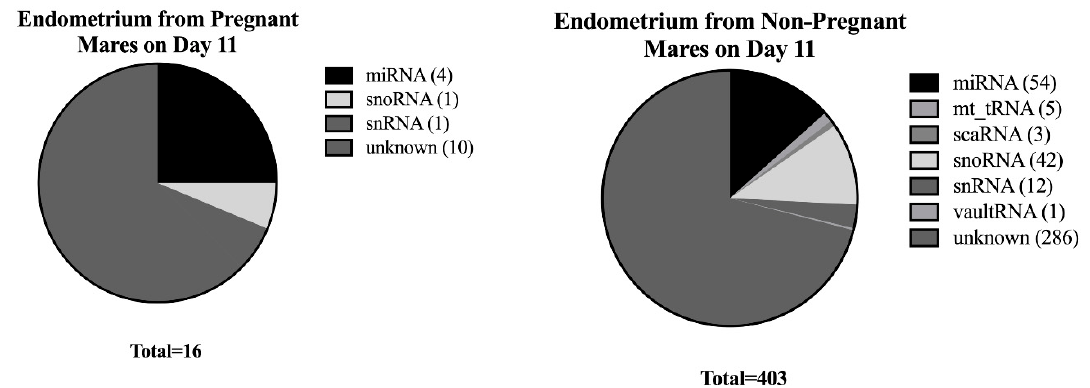
Figure 1. Distribution of differentially expressed families of ncRNA in endometrial samples on day 11 from both pregnant and non-pregnant mares. This figure represents the families of ncRNA differentially expressed ( p ≤ 0.05) in endometrial samples on day 11.